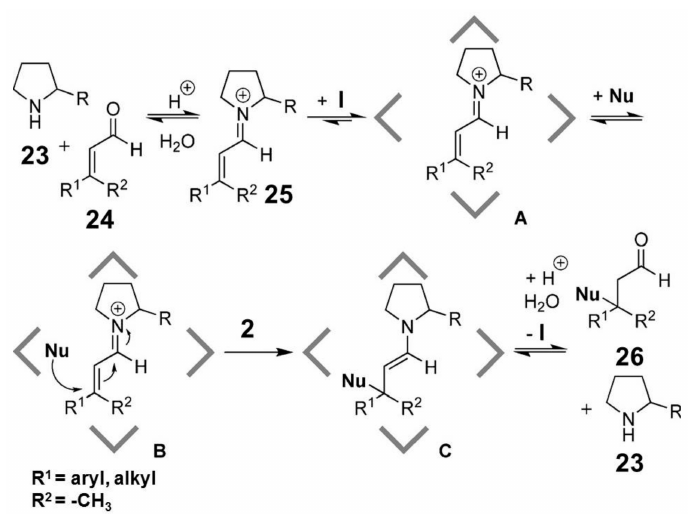
Scheme 9. Proposed pathway of the iminium-catalyzed reaction inside hexameric capsule 2 (Adapted from Ref. [28], with permission of John Wiley and Sons).